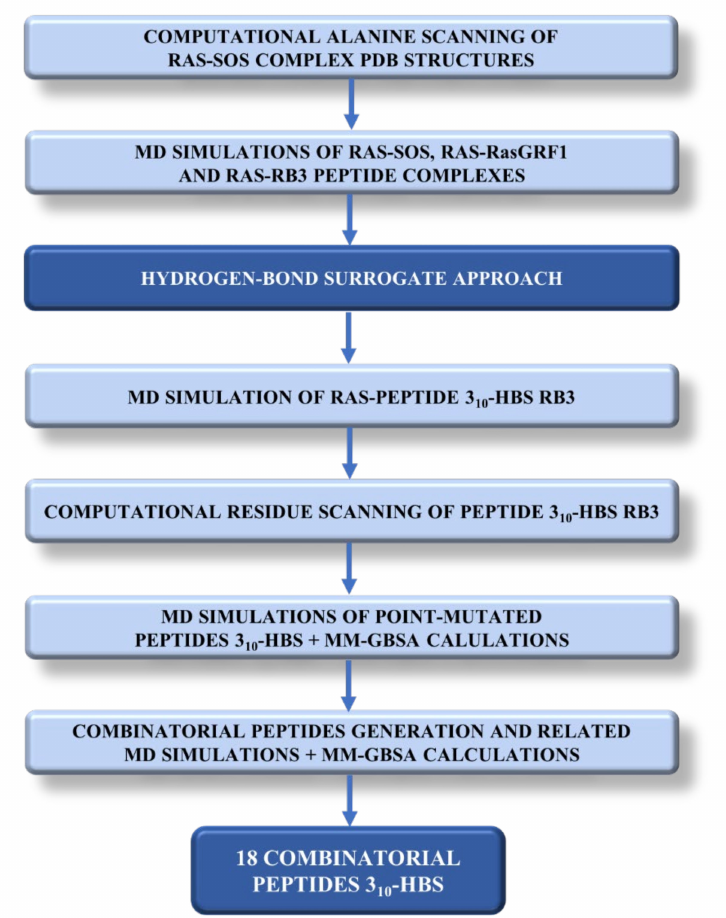
Scheme 1. Overview of the computational workflow performed to identify potential peptide-based modulators to inhibit Ras-RasGRF1